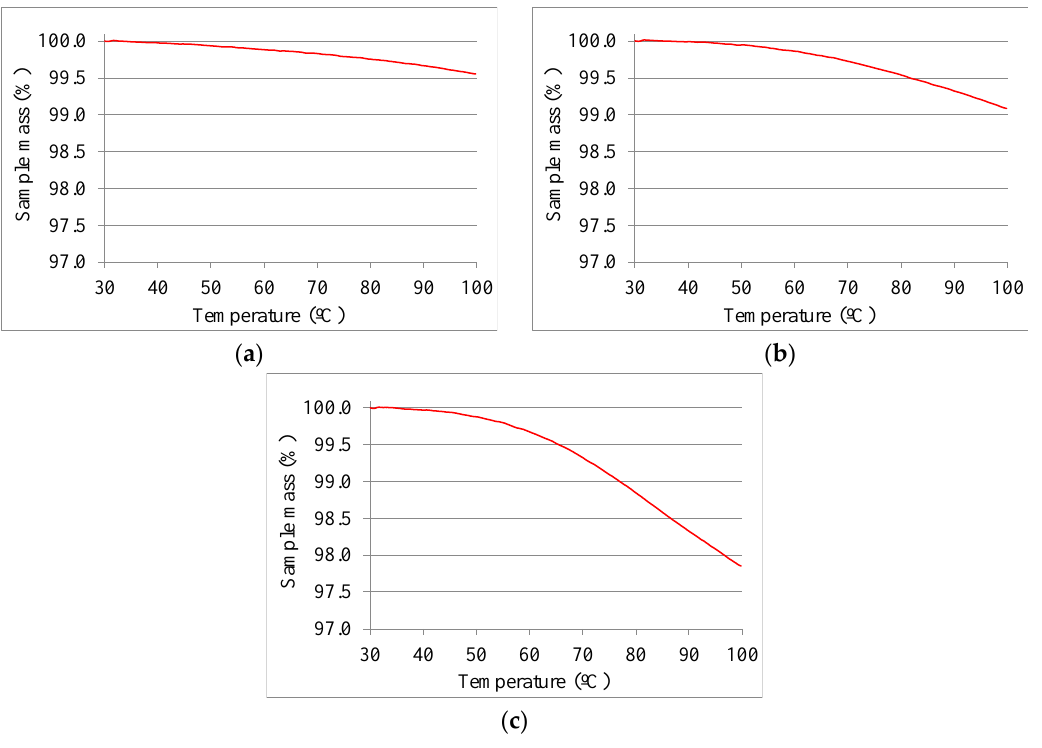
Figure 3. TGA of the PCM candidates for the MED system. ( a ) savE OM 03; ( b ) RT4; ( c ) RT3HC_1.